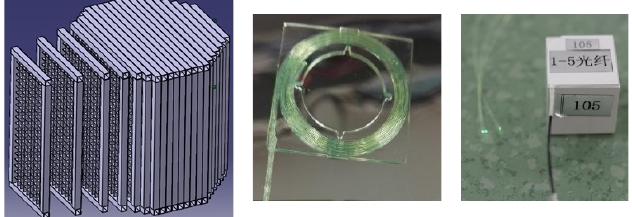
Figure 3. Sketch of the crystal array of the HERD calorimeter. It will consist of 21 layers of cubic LYSO crystals with 3 cm sides (left). Three WLSFs reshaped into spirals are coupled to one side of the crystal (center). The crystal sides are covered with reflectors to increase the light output